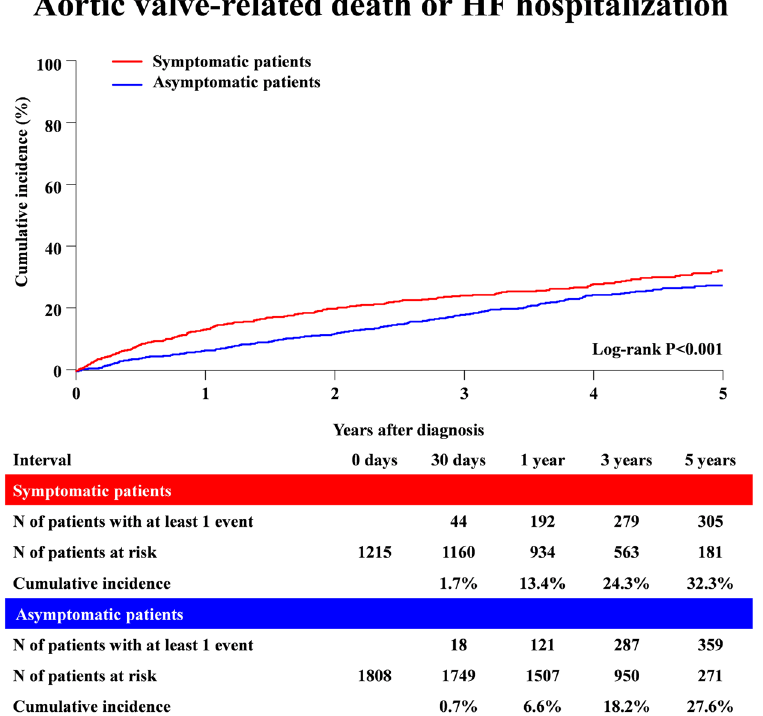
Figure 3. Cumulative incidence of the primary outcome measure (aortic valve-related death or HF hospitalization): Symptomatic versus Asymptomatic patients. HF = heart